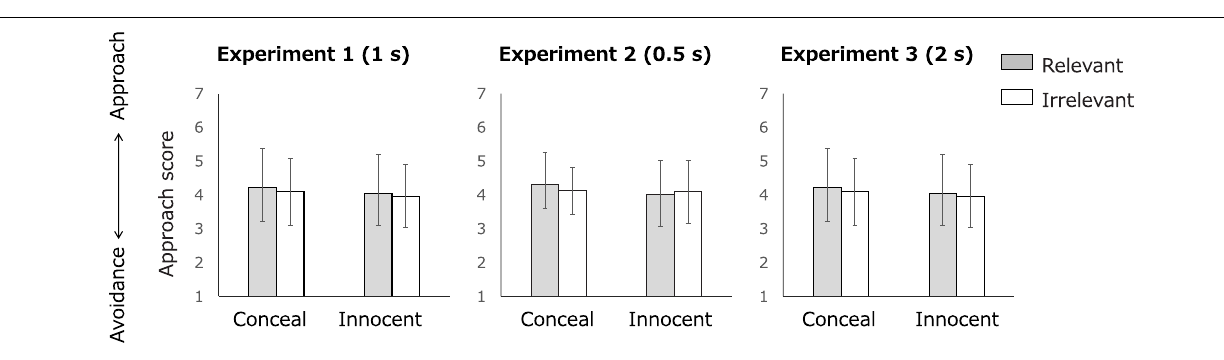
FIGURE 4 | Subjective motivation direction for each condition and each item. Error bars denote standard